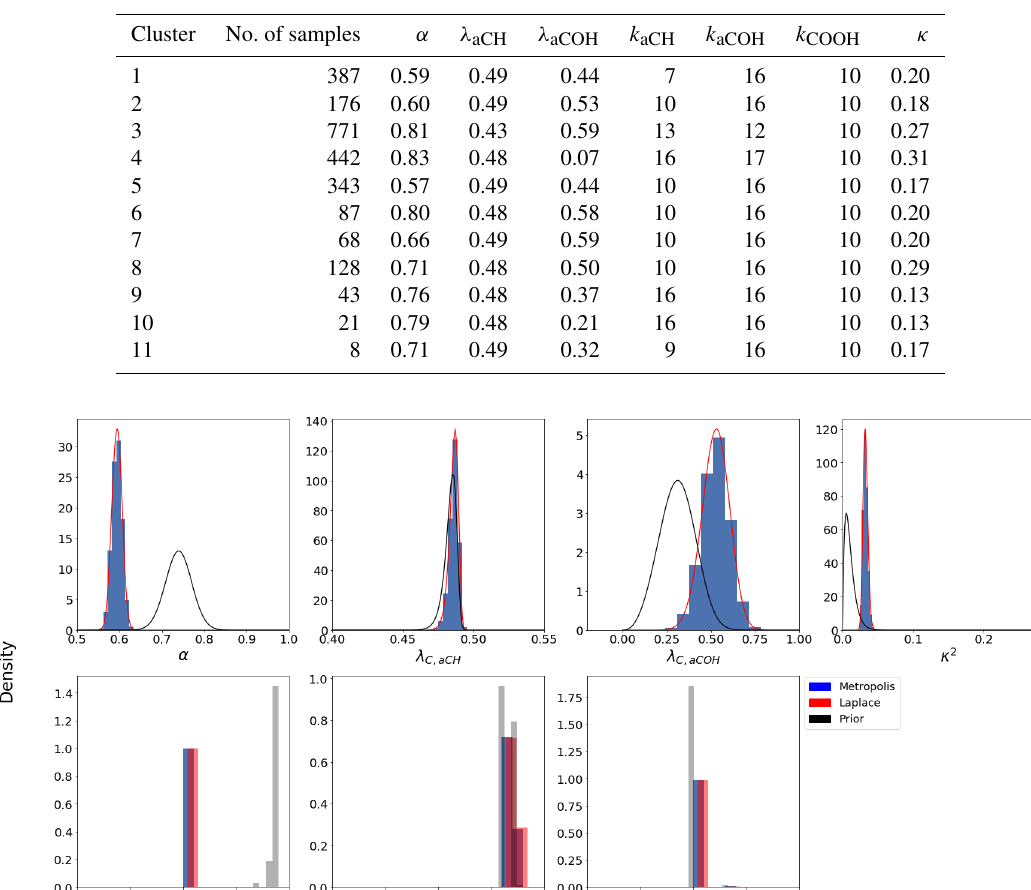
Table 1. Mode of parameter posterior distributions for each cluster.